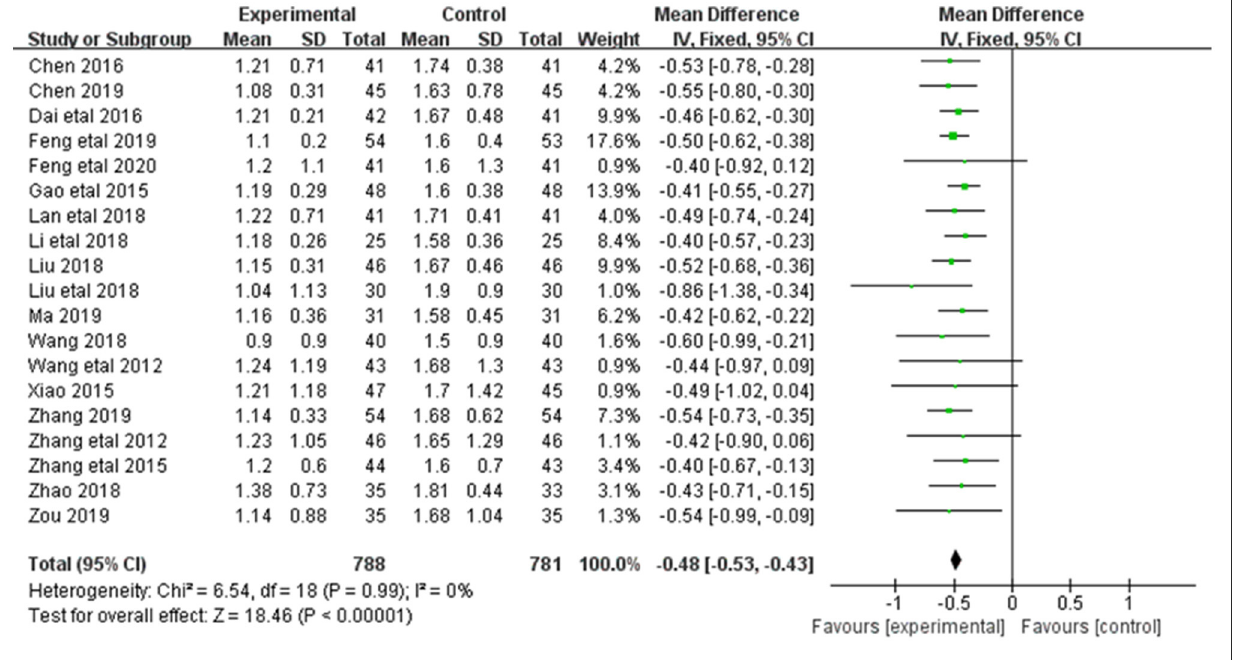
FIGURE6 Forest plot of analysis of the Upro of CHF.